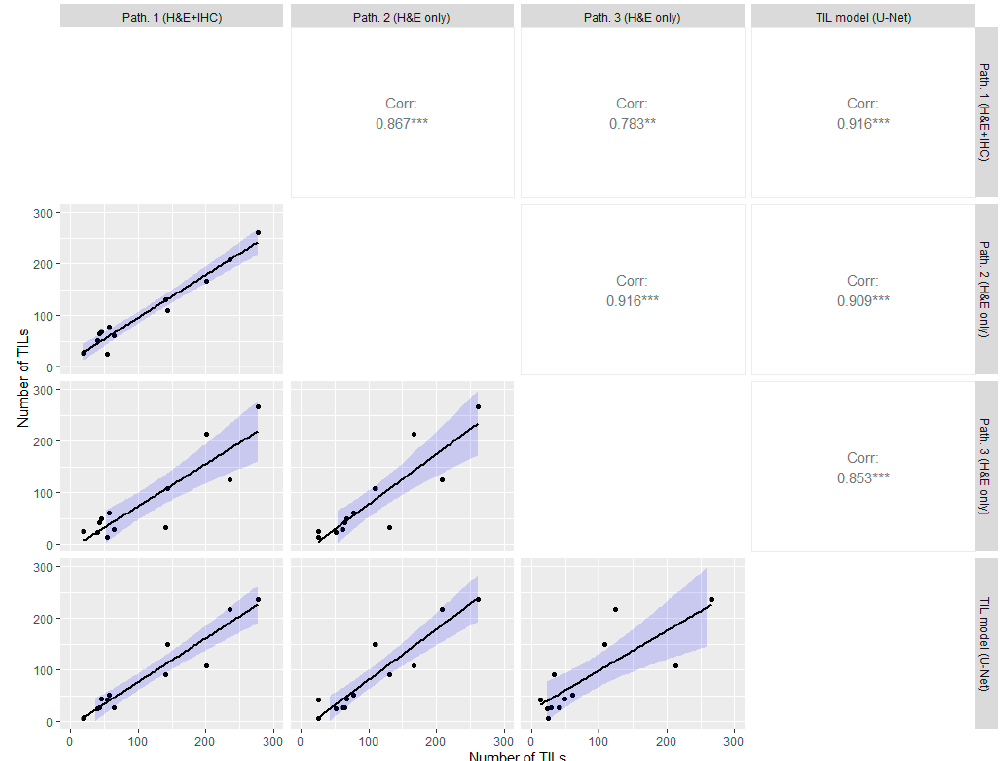
Figure 4. Inter-method variability of cell-level discrimination of TILs between the pathologist with both H&E and IHC, the two pathologists with only H&E, and our image analysis approach on a holdout test set. The lower left of the diagonal shows the correlations plot, and the upper right shows the Spearman correlation coefficient for each comparison. The asterisks ** ( p ≤ 0.01) and *** ( p ≤ 0.001) indicate the significance levels of the statistical correlation test.